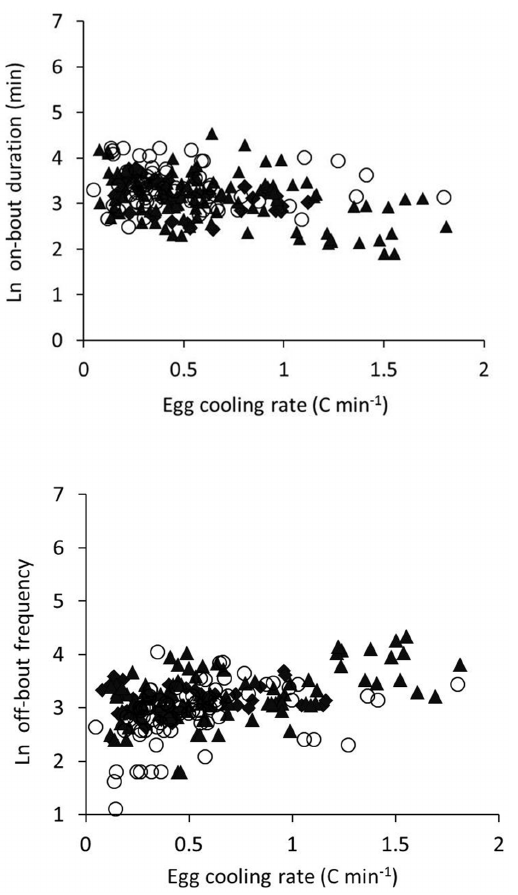
Figure 2. Off-bout frequency and on-bout duration as func- tions of egg-cooling rate. Log-normalized number of daily off-bout duration (bottom) and mean daily on-bout duration (top) for 21 clutches of black-capped chickadees as functions of mean daily egg- cooling rate ( u C min 2 1 ). The number of daily off-bouts increased and on-bout duration decreased as clutch cooling rates increased.